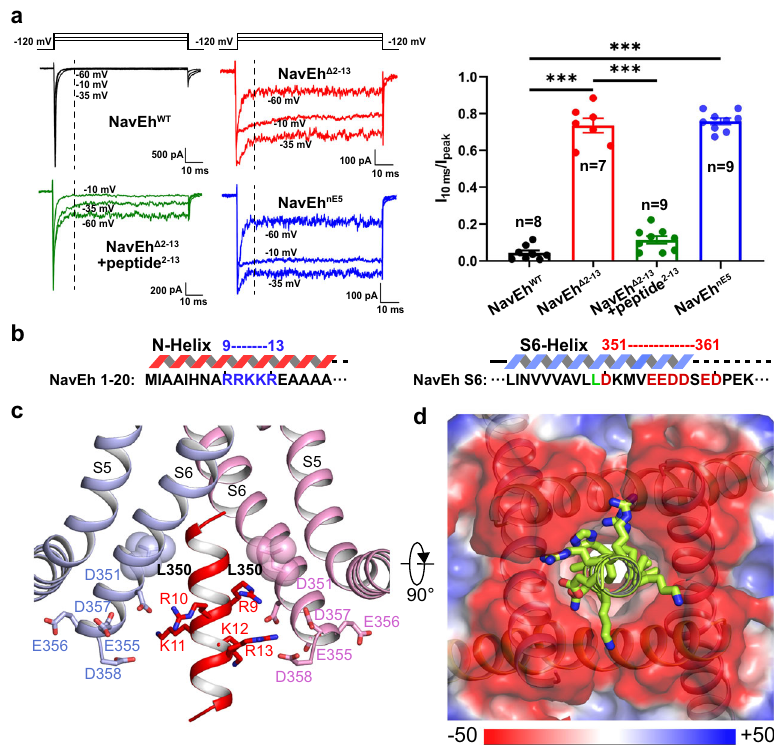
Fig. 4 N-helix determines fast inactivation of Na V Eh. a Functional characteristics of Na V Eh variants. Representative current traces measured at − 65 mV, Δ 2 – 13 , Na Δ 2 – 13 + peptide 2 – 13 and Na − 35 mV, and − 10 mV for Na WT , Na nE5 , respectively. The ratio of current at 10 ms (I V Eh V Eh V Eh V Eh 10 ms ) over peak current (I peak ) measured at − 35 mV were shown in the right panel. Each dot represents a single-cell recording. Signi fi cances were determined using two- sided, unpaired t -test. *** P = 1.9 × 10 − 10 (Na V Eh Δ 2 – 13 , n = 7); *** P = 4.0 × 10 − 15 (Na V Eh Δ 2 – 13 + peptide 2 – 13 , n = 9); *** P = 4.9 × 10 − 10 (Na V Eh nE5 , n = 9). Data are mean + / − SEM. b Sequence of Na V Eh N-helix and S6 helix. The positively charged cluster on N-helix and negatively charged cluster on S6 shown in blue and red, respectively. c A close-up view of the N-helix sticks in the gate. Key residues shown side-chains in sticks. Only two opposing subunits are shown for clarity. d Electrostatic potential of the Na V Eh gate from − 50 to 50 kT (red to blue). The yellow N-helix shown side-chains in sticks. Source data are